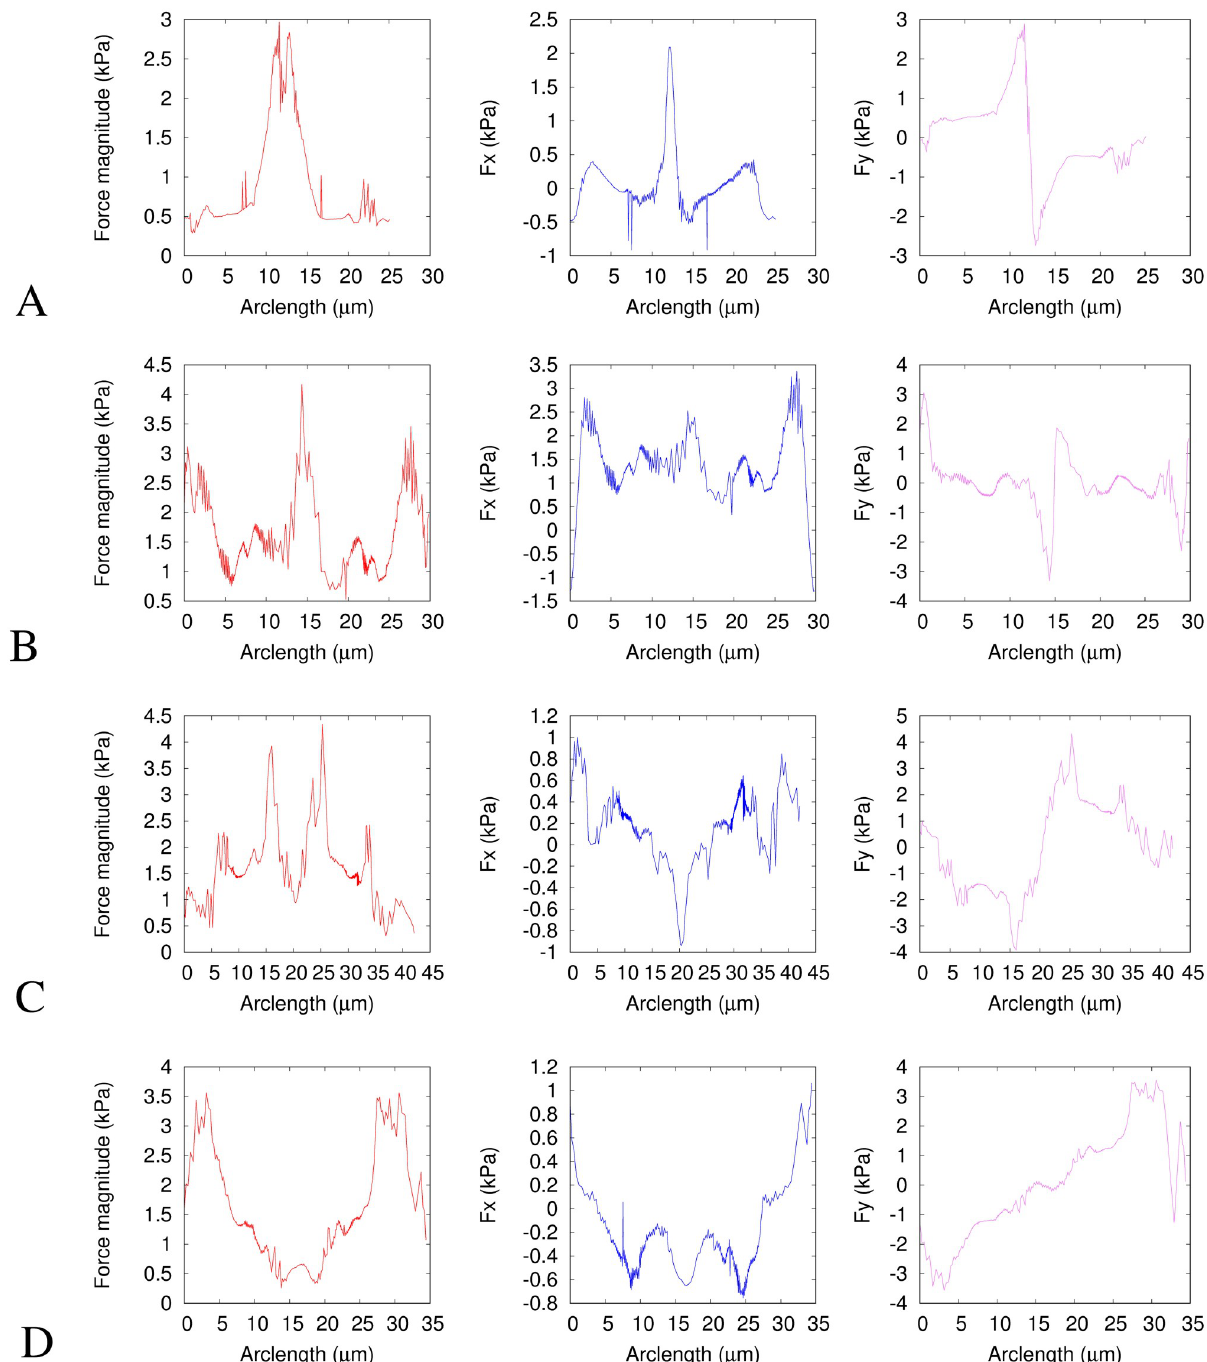
Fig 5. Traction force fields for the solid model. The first column (red curves) shows the traction force magnitudes (the same data as the red arrows in Fig 4). The second column (blue curves) shows the x component of the traction forces (along the channel). The third column (magenta curves) shows the y component of the traction forces (perpendicular to the channel). These are all plotted against the arclength in micrometers. The direction of the arclength coordinate s 1 is anticlockwise as shown in Fig 3. s 1 = 0 corresponds to θ = − π and y = 0 at the rear of the nucleus ( x most negative) in Fig 4. s 1 then increases anticlockwise around the negative y region to the front ( x most positive) then around the positive y region to rear again. The traction force is calculated using a Young’s modulus of E = 5 kPa and assuming that the nucleus behaves as an incompressible elastic solid with a Poisson ratio ν = 0.5. The subfigure rows correspond to the same times as in Fig 4, i.e. A. before to entering constriction, B. entering to within constriction, C. within to exiting constriction and D exiting to after